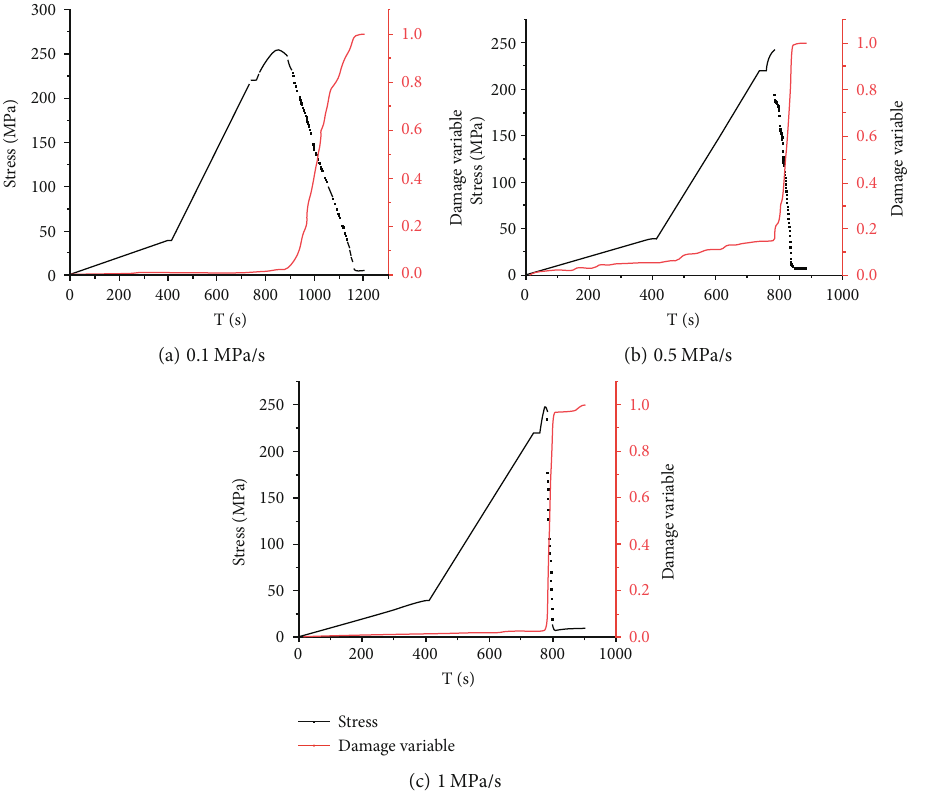
Figure 7: Time-stress-damage variable D relationship curves for limestone under di ff erent unloading rates of the same surrounding pressure.